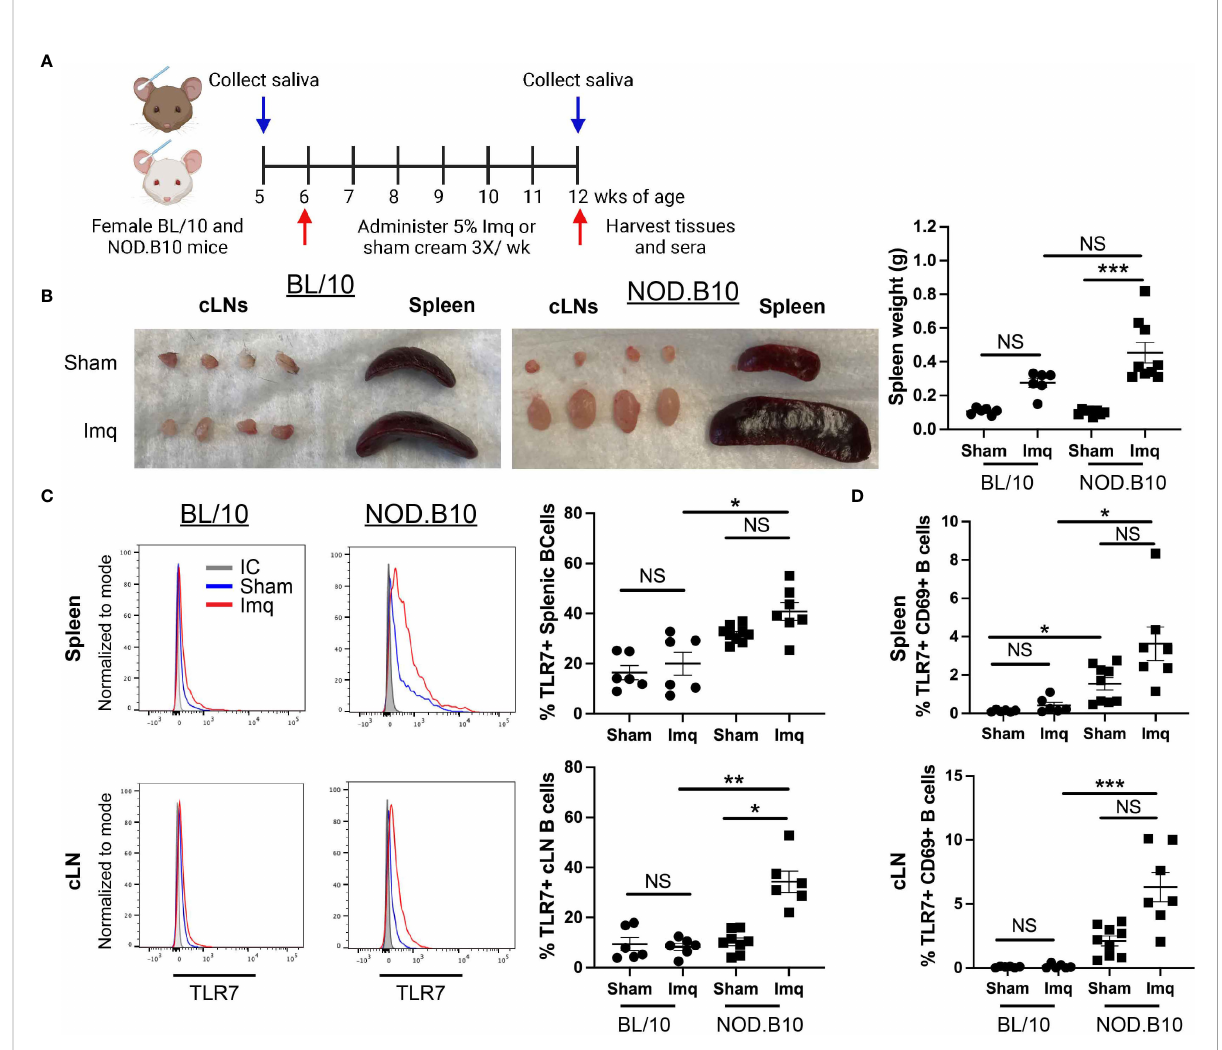
FIGURE 1 TLR7 agonism induces splenomegaly, cervical lymphadenopathy and expansion of TLR7-expressing B cells in NOD.B10 mice. (A) NOD.B10 and BL/10 mice were treated with sham or Imq-containing cream beginning at 6 weeks of age for 6 weeks. The treatment timeline is shown. (B) Representative images of spleen and cLNs from each treatment group and quanti fi cation of spleen weights is shown (n = 6 BL/10 sham, 6 BL/10 Imq-treated, 8 NOD.B10 sham, and 9 NOD.B10 Imq-treated mice). (C) Spleens and cLNs of sham (n = 6 BL/10 and 9 NOD.B10) or Imq-treated mice (n = 6 BL/10 and 7 NOD.B10) were harvested and fl ow cytometry was performed. Cells were gated on B220 and expression of TLR7 is shown. The percentages of B220 + , TLR7 + B cells are quanti fi ed for spleen and cLNs, respectively. (D) Cells were gated on B220, and the percentages of cells in spleen and cLNs expressing TLR7 and CD69 are shown. Horizontal lines represent the mean and SEM (NS, non- signi fi cant, *p < 0.05, ***p < 0.001, and ***p <